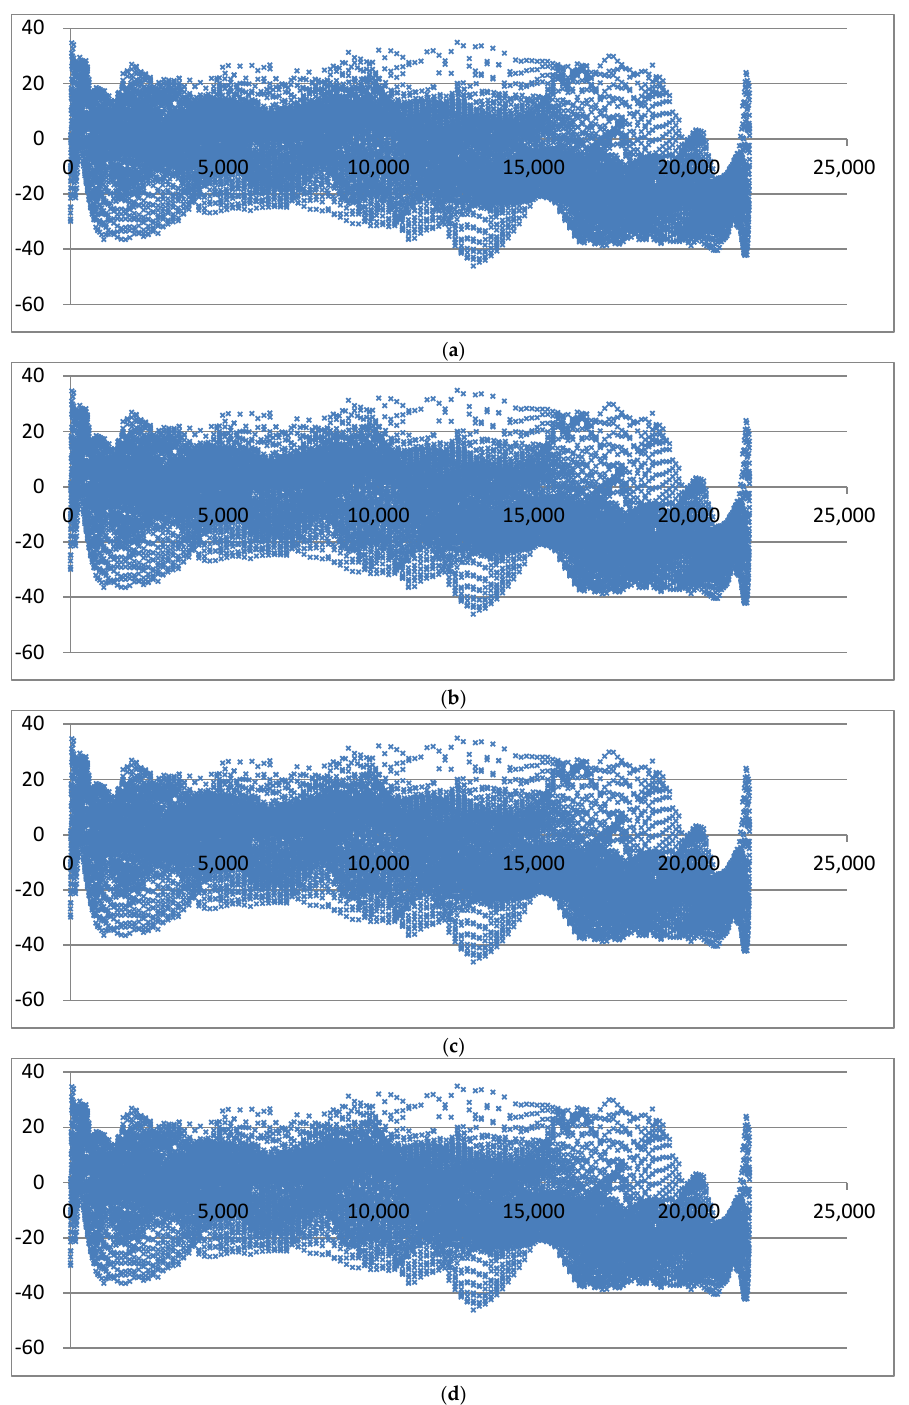
Figure 13. Error distributions of the interpolation results shown in Figure 11. ( a ) Error distribution of IDW interpolation; ( b ) error distribution of kriging interpolation; ( c ) error distribution of triangular prism linear interpolation; ( d ) error distribution of triangular prism quadric interpolation.